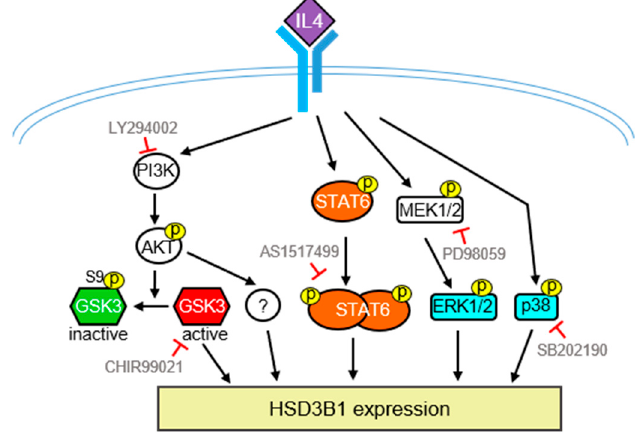
Figure 7. Schematic model of the signaling pathways involved in the IL4-induced HSD3B1 expression in HT-29 cells. Upregulation of IL4-induced HSD3B1 expression involves PI3K/AKT, STAT6, ERK1/2, and p38. GSK3 positively regulates IL4-induced HSD3B1 expression; however, GSK3 is inactivated upon activation of AKT at the early stage of IL4 stimulation. Therefore, GSK3 contributes to an elevated HSD3B1 expression during the late period of IL4 stimulation. Some downstream effectors of PI3K/AKT important for IL4-induced HSD3B1 expression have yet to be identified.